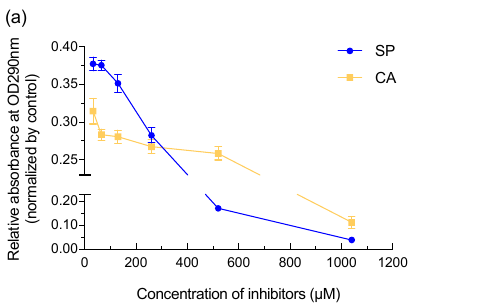
Figure 5. ( a ) Relative abundance of scopoletin (blue) and chlorogenic acid (yellow) on XO-catalyzed UA formation. ( b ) Inhibition of scopoletin (blue) and chlorogenic acid (yellow). IC 50 : concentration of the compounds, which induced 50% inhibition of UA formation. Symbols represent the data under corresponding concentrations and error bars indicate the mean ± SD.